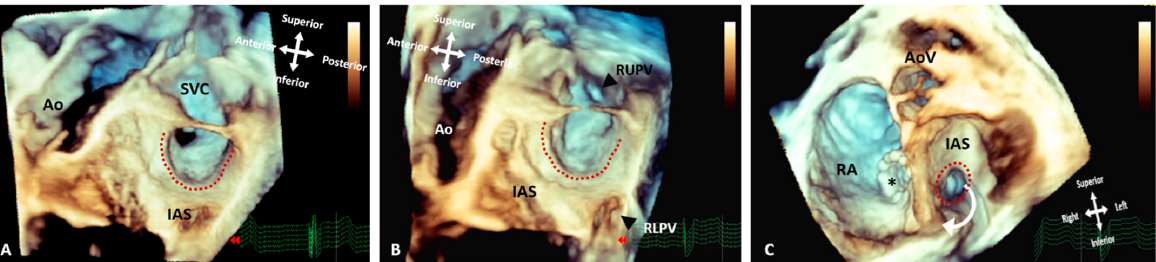
Figure 7. Three-dimensional rendered images from TOE demonstrating the appearance of Superior Sinus Venosus ASDs before and after stenting. ( A ) Demonstrates a superior sinus venosus ASD as outlined by the dashed line–seen from the left atrial aspect. ( B ) Illustrates that careful imaging and angulation allows visualization of the right pulmonary veins (arrowheads), the anomalous RUPV and the RLPV draining into the LA. ( C ) An image seen from the ventricle with the AV valves re- moved allowing visualization of the roof of the atria. A covered stent in situ within the SVC extend- ing into the RA (asterisk) and the unoccluded defect (dashed line) allowing the anomalous vein to drain around the stent back into the LA. All images are shown in anatomic orientation. Ao: Aorta; AoV: Aortic valve; AS; Interatrial septum; LA: Left atrium; RA: Right atrium; RLPV: Right lower pulmonary vein; RUPV: Right upper pulmonary vein and SVC: Superior vena cava.